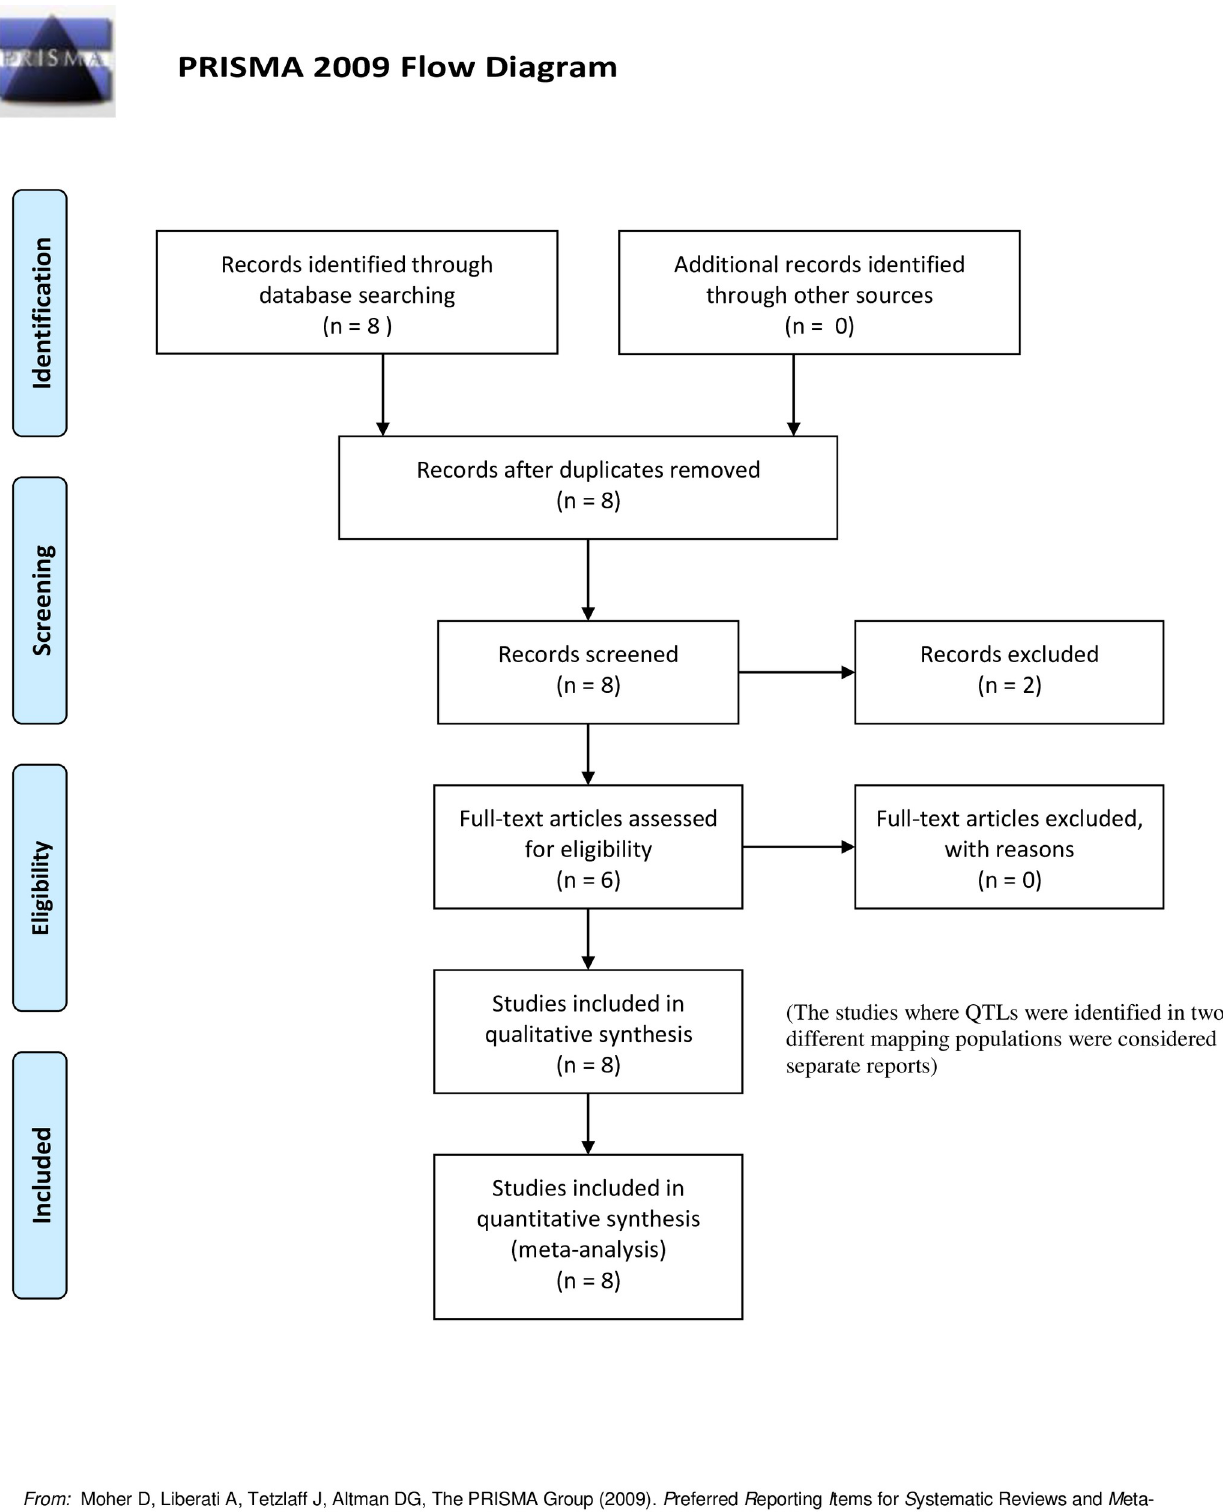
Fig 1. Flow diagram of studies assessed and included. https://doi.org/10.1371/journal.pone.0256389.g001 PLOS ONE | https://doi.org/10.1371/journal.pone.0256389 August 19,